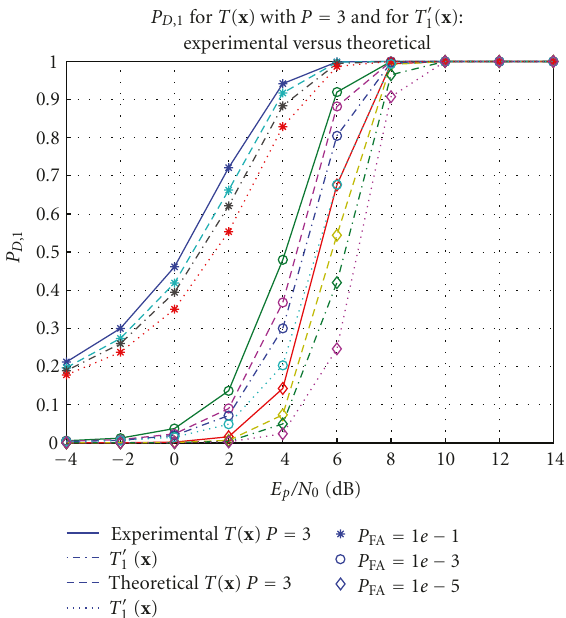
Figure 9: MSE performance for channel estimation with di ff erent lengths.